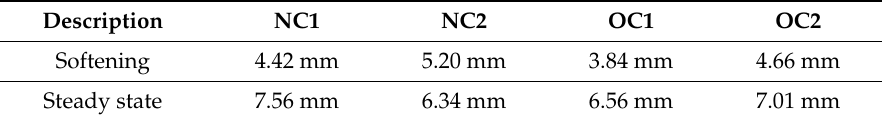
Table 4. Thickness of shear band for each